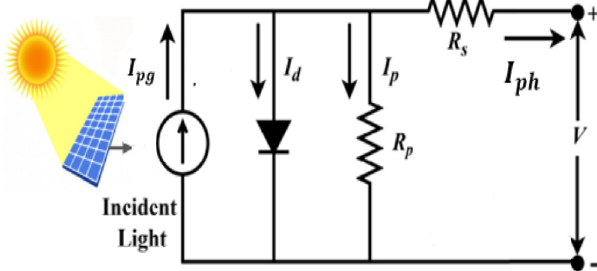
Fig. 4. Electrical equivalent circuit model of a photovoltaic